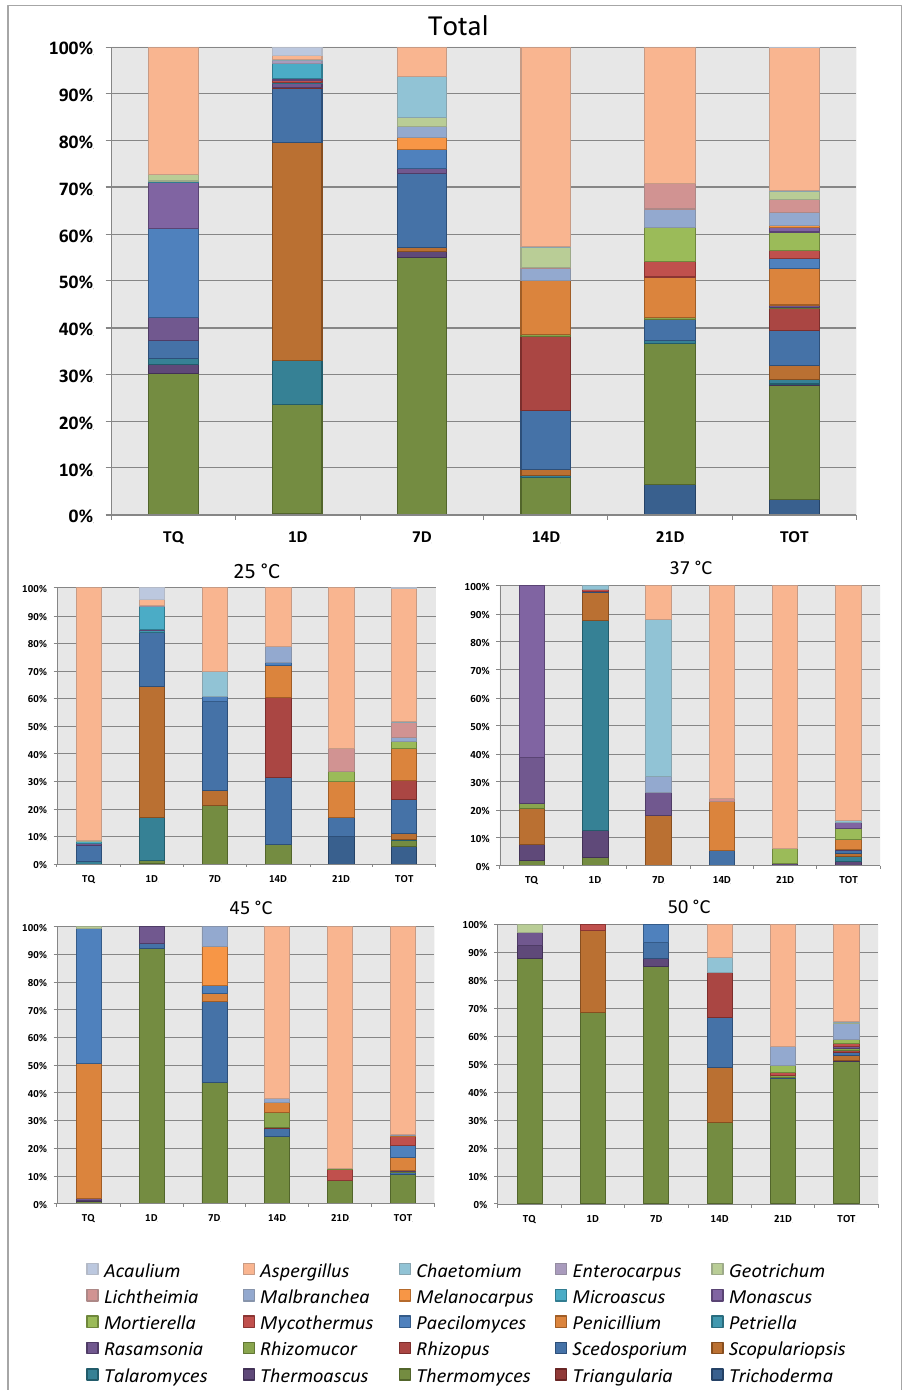
Figure 1. Percentage distribution by genera of filamentous fungi isolated during maturation period: total and detail for each temperature of incubation. Table 3. Shannon’s biodiversity index (H’) and evenness (E) of analyzed samples detailed at different temperatures, and cumulative samples (TOT).